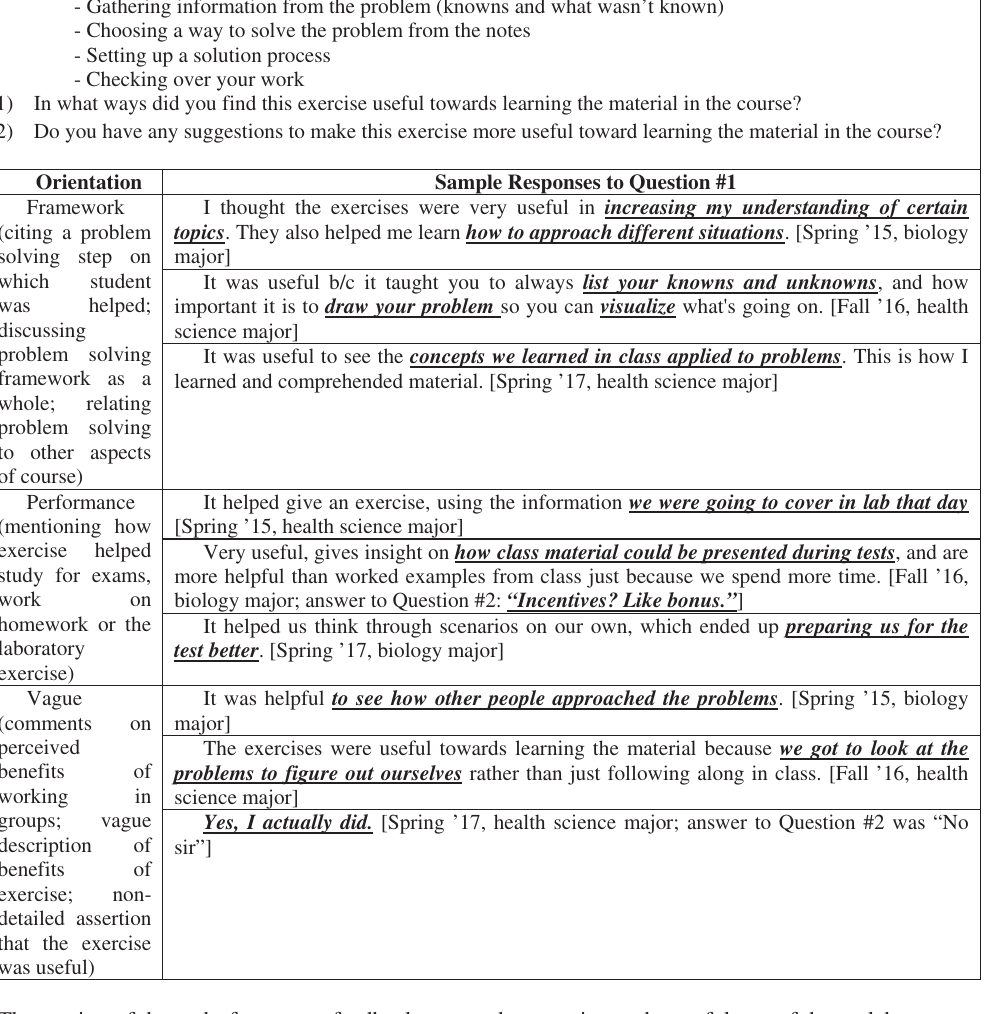
FIG. 3. (Top) The portion of the end-of-semester feedback survey that pertains to the usefulness of the prelaboratory group problem- solving exercise. (bottom, left) The three learning orientation categories, including criteria that served to classify student responses as belonging to a respective category. (bottom, right) Sample self-reported statements of students in response to question 1, including highlighted language that meet the criteria of the orientation category in which the student is classified. Basic information about each student, and answers to question 2 where pertinent, are included in